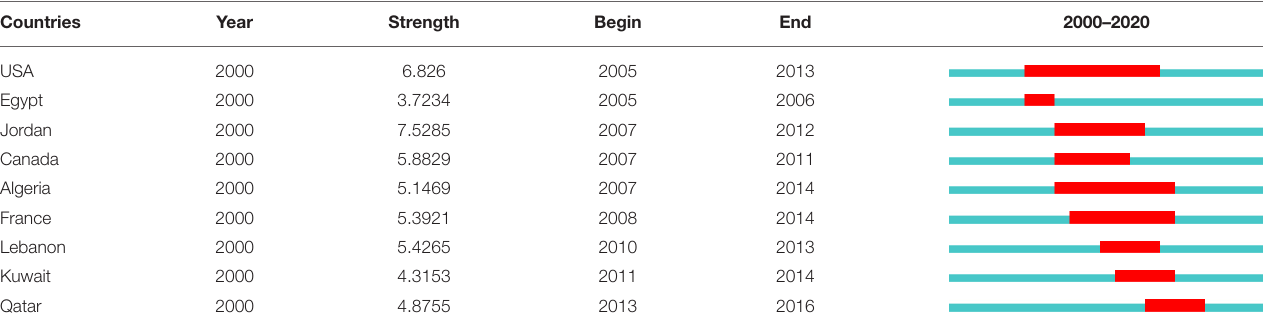
TABLE 2 | Countries showing citation